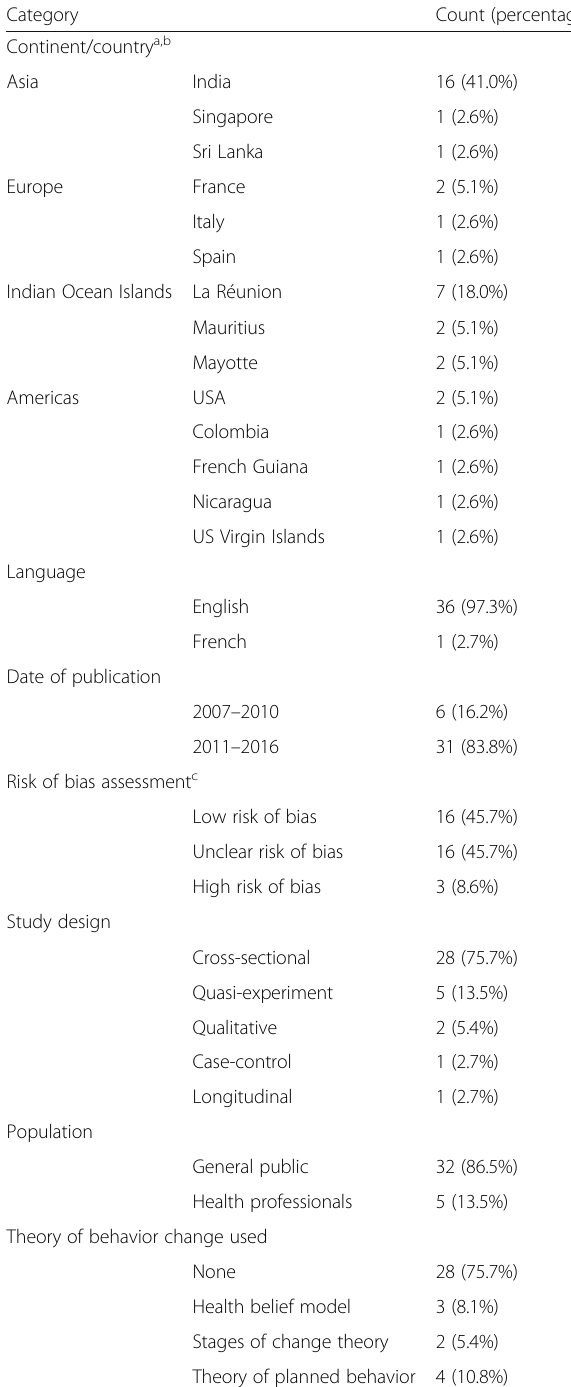
Table 1 General characteristics of 37 included primary